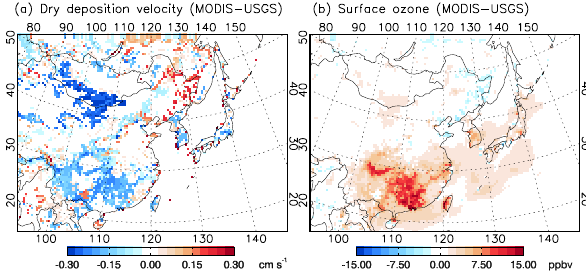
Figure 6. Differences in dry deposition velocity (left) and monthly mean O 3 concentration in the surface air (right) between the MODIS and USGS land-use data using the Wesely scheme for May